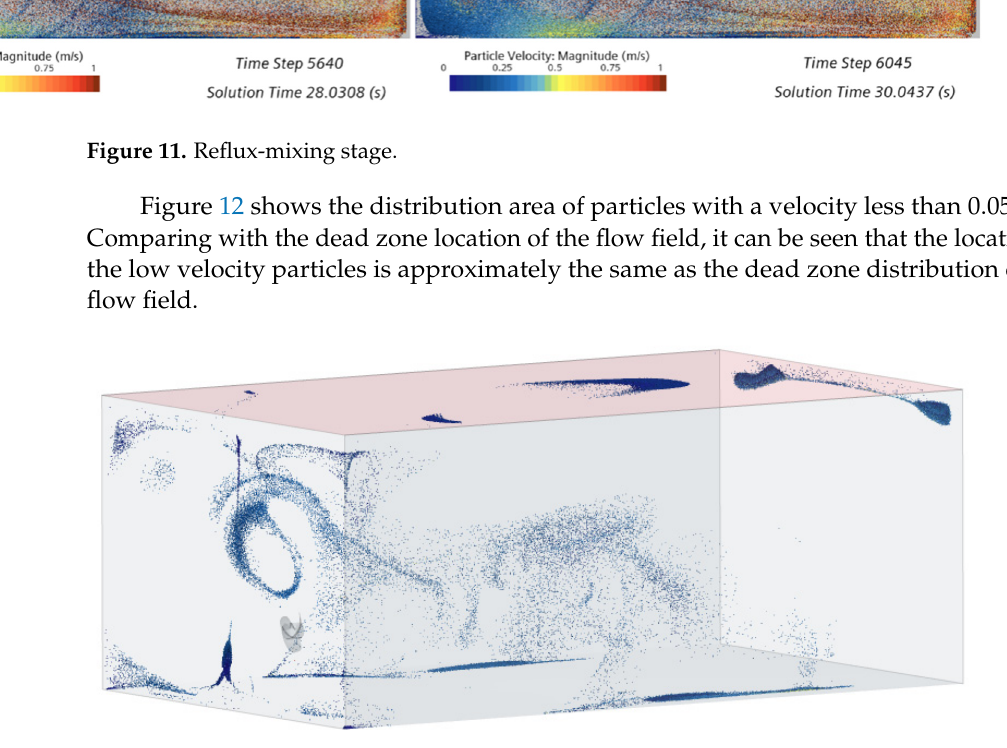
Figure 12. Distribution area of low velocity particles.